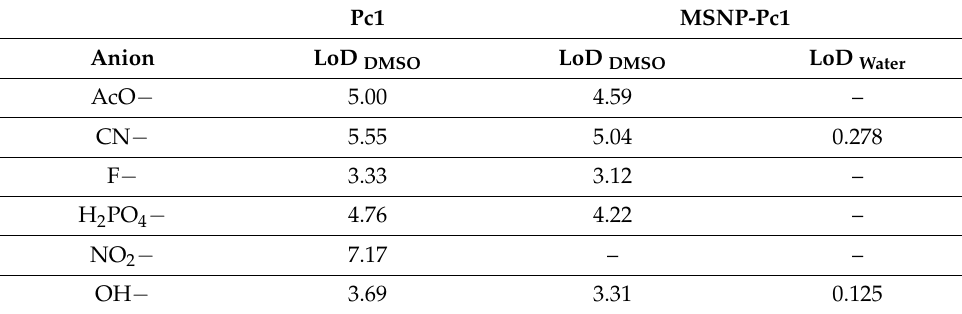
Table 2. Limit of detection ( µ M) for Pc1 and MSNP-Pc1 in DMSO and water.